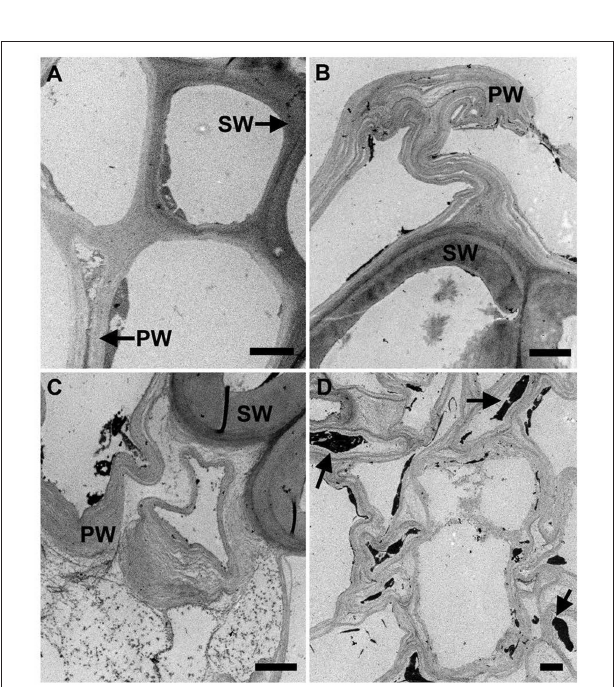
FIGURE 4 | Transmission electron microscopy images of untreated (A) and EA pretreated (B–D) of corn stover stems images. TEM images showed that primary walls (PW) were severely affected after pretreatment. Secondary walls (SW) remained more resistant to EA pretreatment. Delamination and kinking in the primary walls were observed. Cell walls lost their integrity and empty spaces can be seen in the wall. Bar = 2 µ m in all images. Sections were post-stained with uranyl acetate, and potassium permanganate (selectively stains